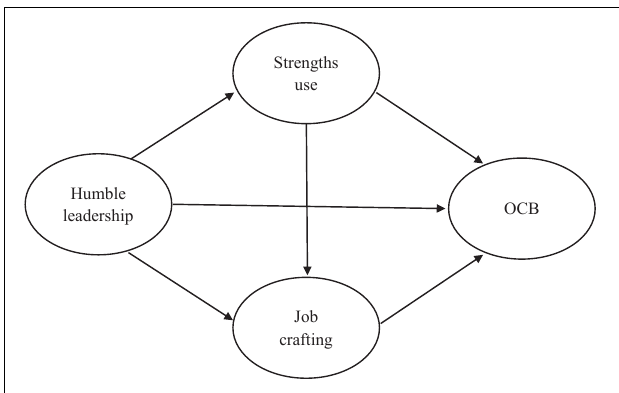
FIGURE 1 | The proposed model.